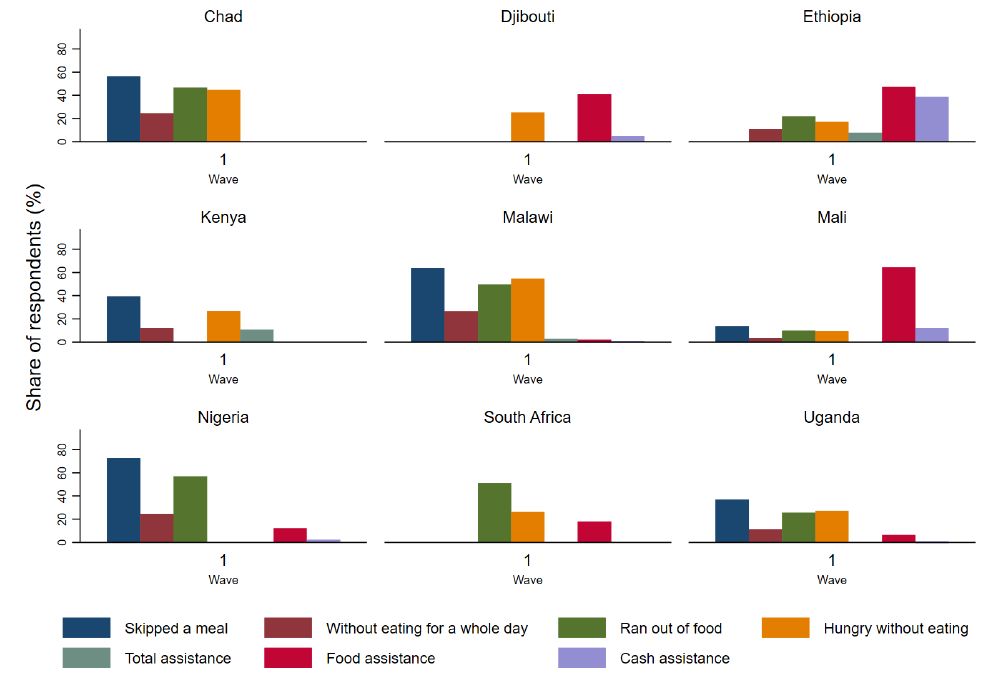
Figure 2. Food insecurity and safety nets at the beginning of the